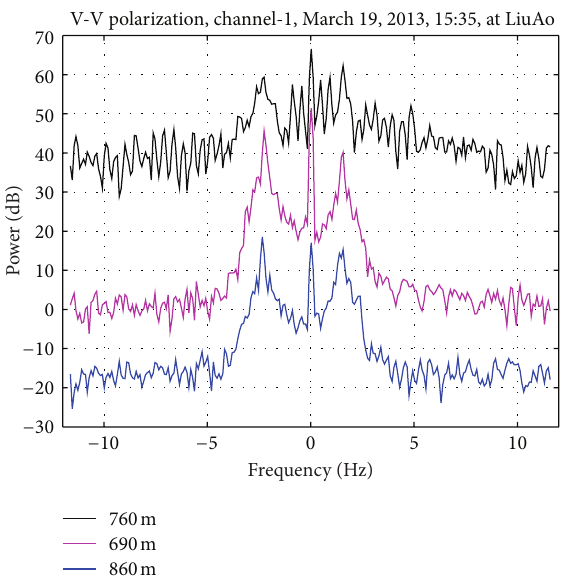
Figure 2: Echo power versus Doppler frequency.